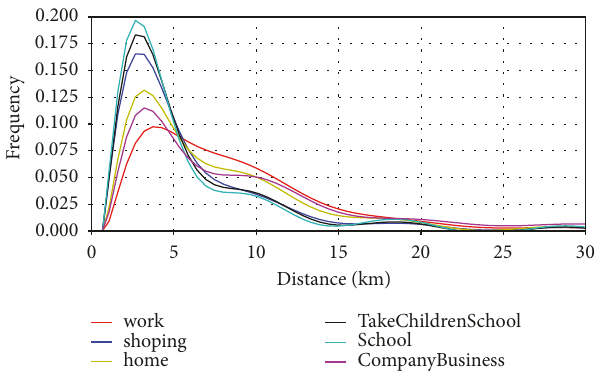
Figure 10: Comparison of travel distance with different purpose by bus.